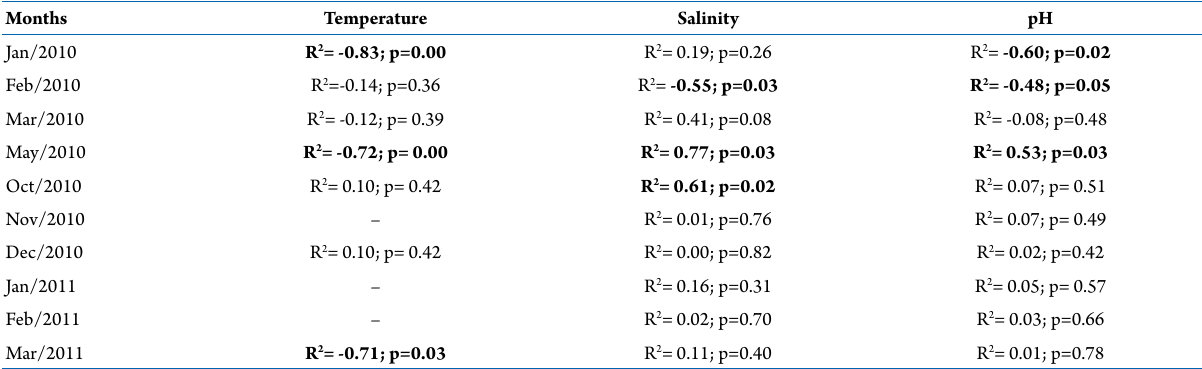
Figure 3. Relationship between temperature, salinity, and pH and their effect on the abundance of Cirripedia larvae over the Table 1. Spatial variation correlations between abiotic data (Temperature, Salinity, and pH) and Cirripedia larvae over the sampled months.